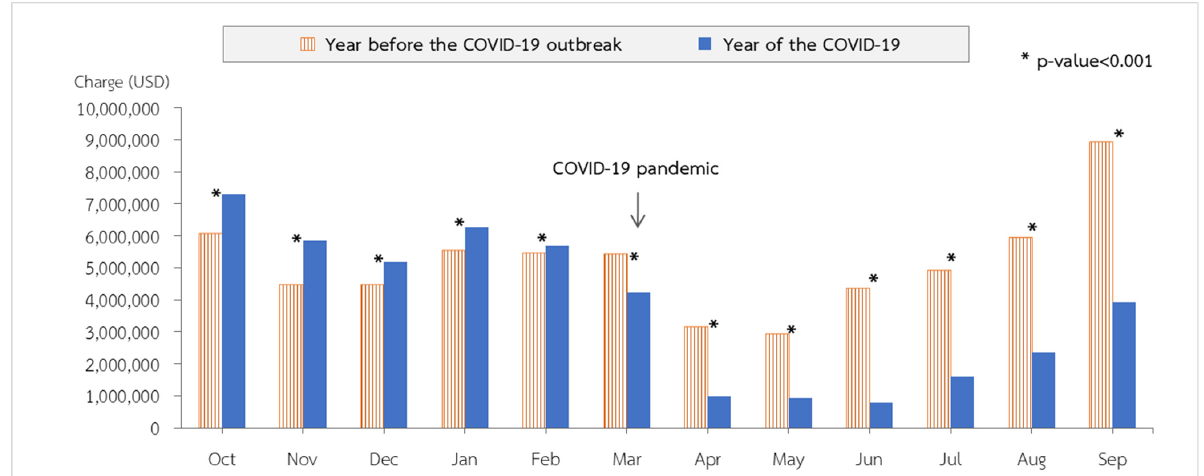
Figure 3. Total costs of all lower respiratory infections by month in fiscal year 2019 compared with 2020 in Thailand.